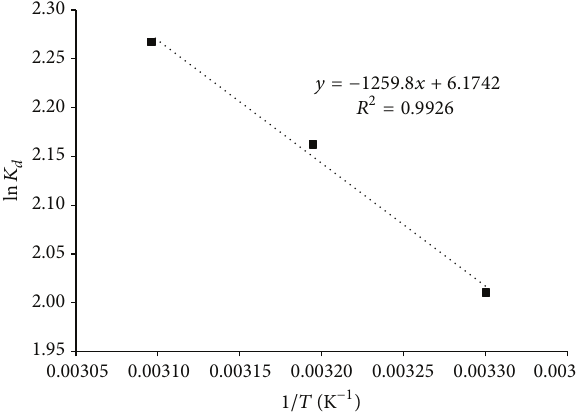
Figure 15: Thermodynamic plot for adsorption of lead ions onto CCRWSD (pH = 5.6, dose = 0.5 g/L, contact time = 180min, and concentration = 20 mg/L). Table 3: Thermodynamic parameters for lead adsorption (pH = 5.6, dose = 0.5 g/L, contact time = 180min, and concentration = 20 mg/L).